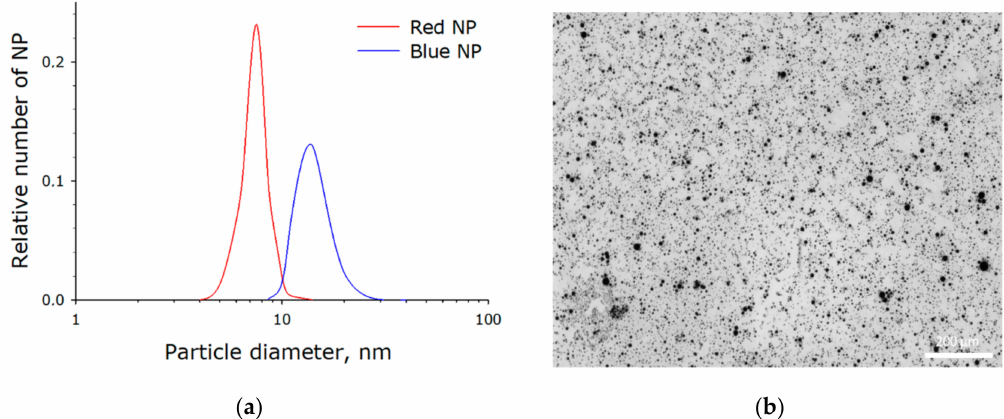
Figure 1. Size distribution of nanoparticles of fluorophores. ( a ) Size distribution of nanoparticles of fluorophores obtained using dynamic light scattering. Red NP-fluorophore nanoparticles with emission in the red region of the spectrum. Blue NP-fluorophore nanoparticles with blue emission. ( b ) TEM photograph of a preparation of a fluorophore containing nanoparticles with emission in both the red and blue spectral